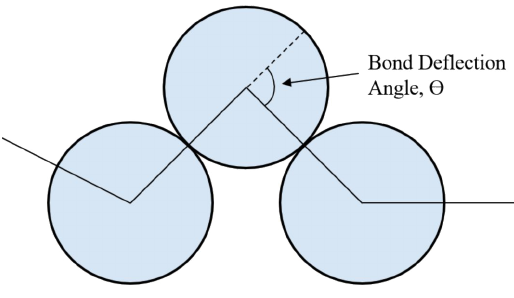
Figure 1. Bead-spring model with bonds (lines connecting the centers of bonded beads). Bond deflection angle θ is limited by repulsive interactions between next-neighbor beads to about 120 ◦